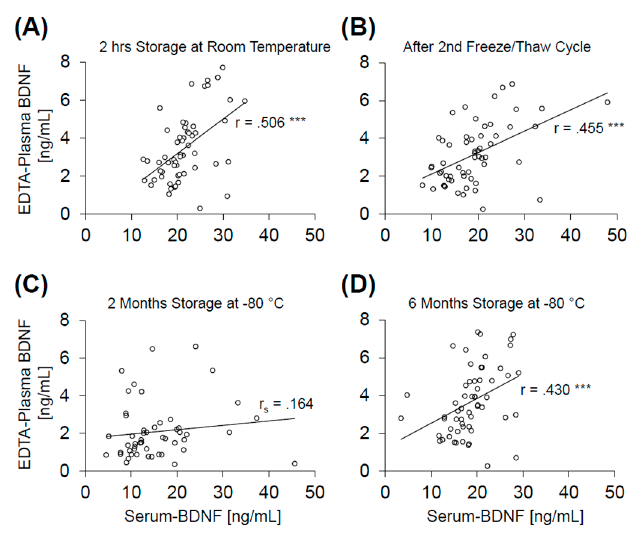
Figure B3. Correlations of serum and EDTA-plasma BDNF concentrations for time points ( A ) “2 hrs storage at room temperature” (T2), ( B ) “After 2nd freeze/thaw cycle” (T3), ( C ) “2 months storage at − 80 °C” (T4), ( D ) “6 months storage at − 80 °C” (T5). BDNF: brain-derived neurotrophic factor, EDTA: ethylenediaminetetraacetic acid, hrs: hours.